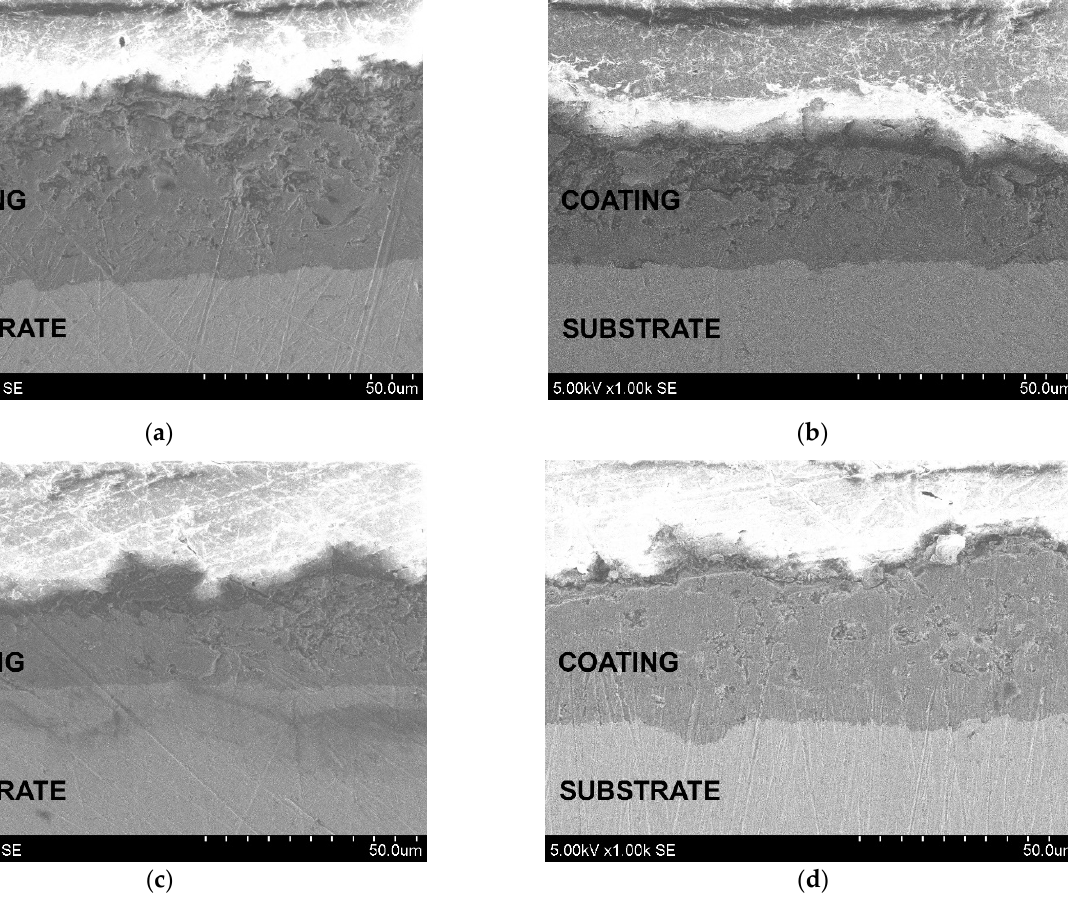
Figure 6. Cross-sections of coating surfaces using different plasma torch input powers: ( a ) 29.4 kW; ( b ) 33.6 kW; ( c ) 42.0 kW; and ( d ) 45.1.